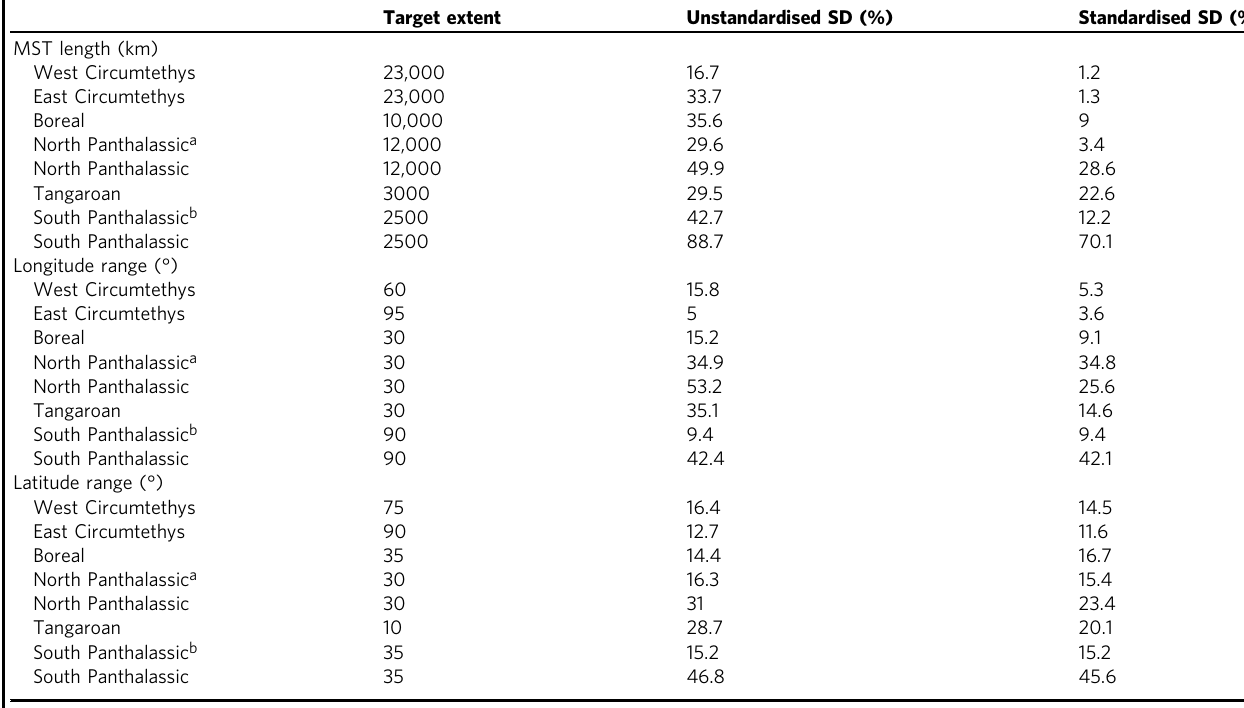
Table 1 Target extent and ef fi cacy for minimum spanning tree (MST) and longitude – latitude